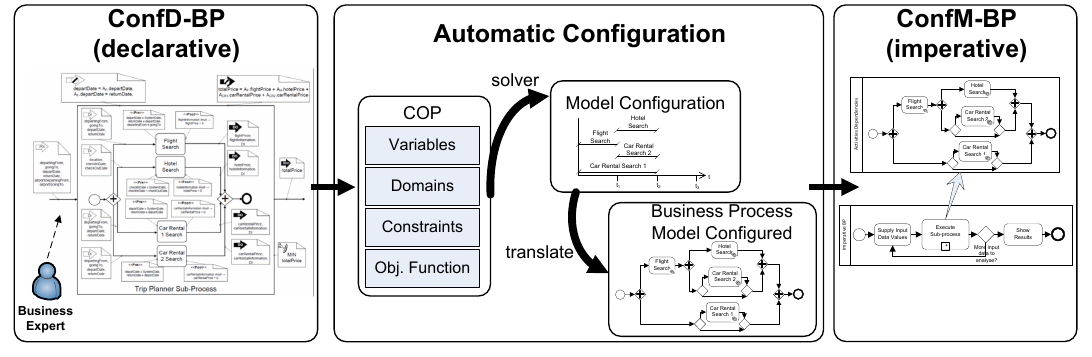
Figure 1. Conf-BP Architecture.